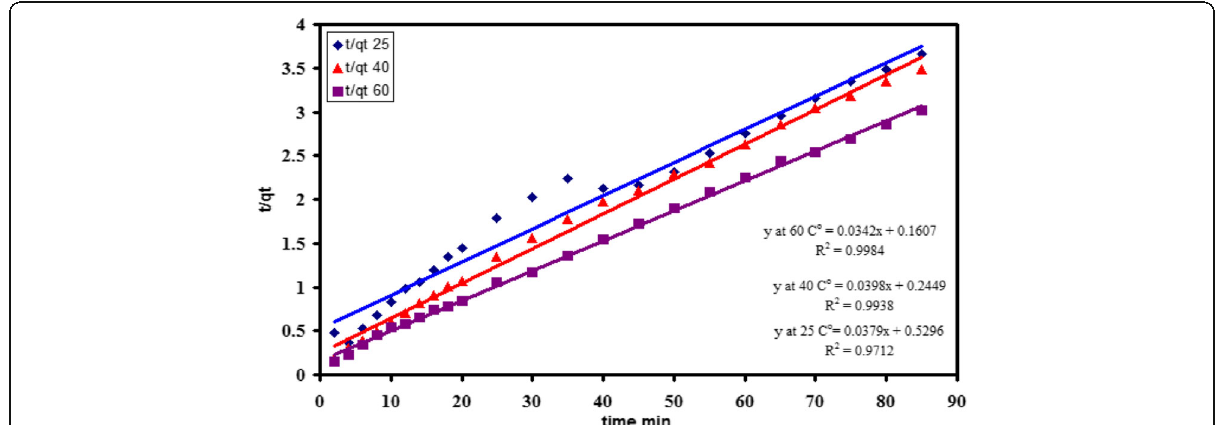
Fig. 11 Pseudo-second-order model plot at different temperature of adsorption AO67 onto RPSF [pH = 2.5, concentration 100 mg/L, and adsorbent dose 0.2